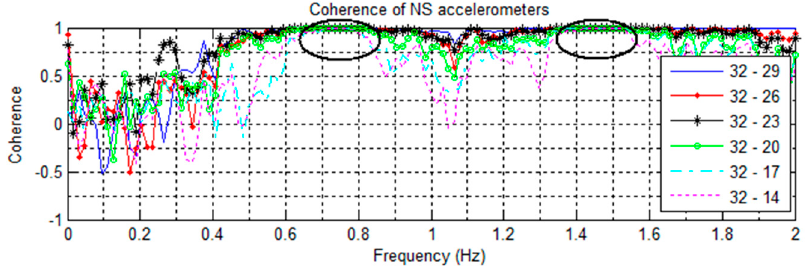
Figure 5. Coherences of NS oriented accelerometers paired against the floor 19 sensor; from